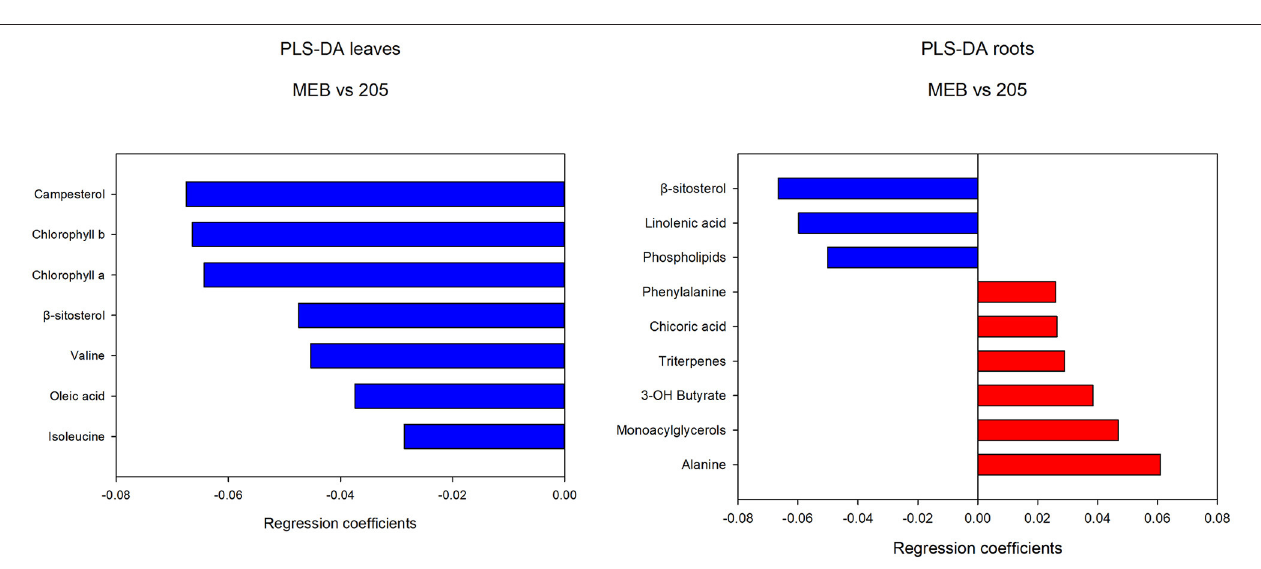
FIGURE 3 | PLS-DA regression coefficients of significantly different metabolites in chicory leaf and root extracts of MEB (control) and C. globosum